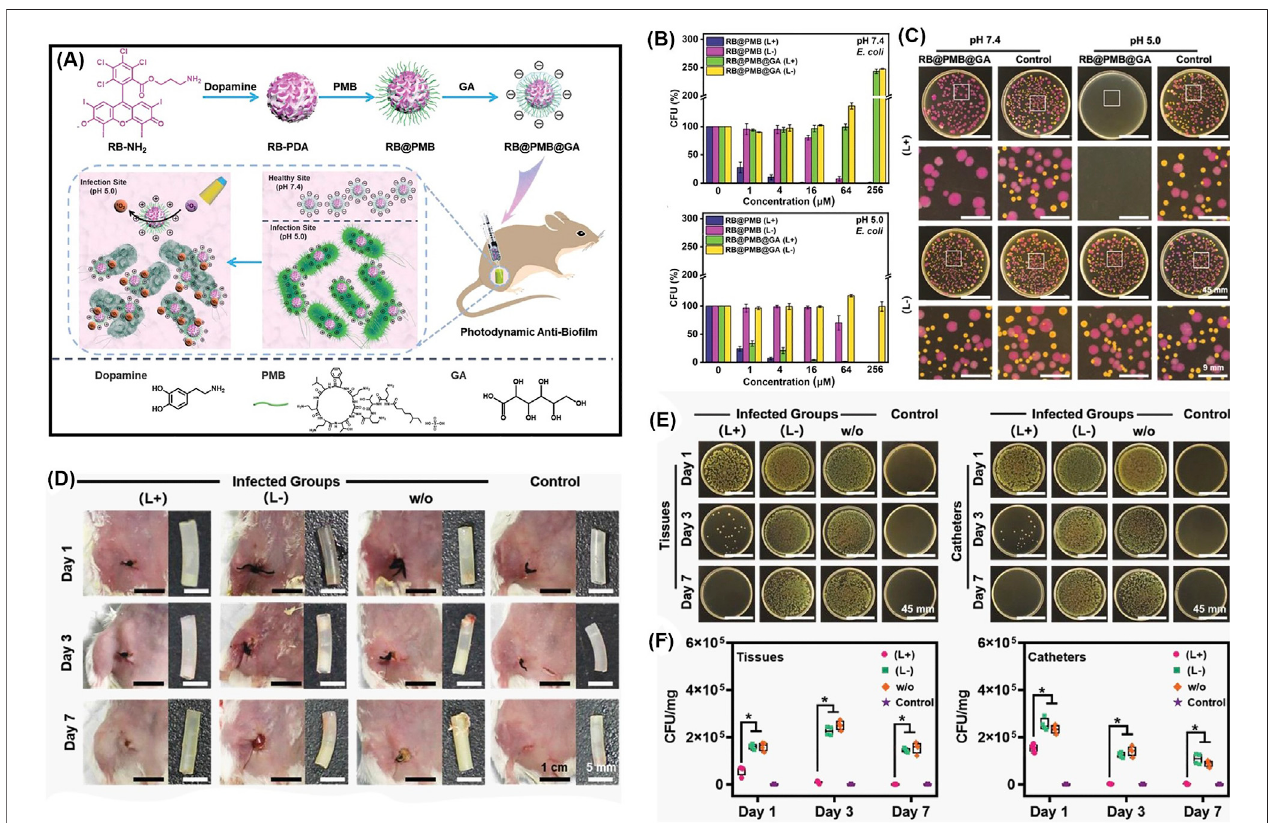
FIGURE 14 | (A) Schematic illustration of the preparation process of photodynamic NPs for enhanced penetration and antibacterial ef fi ciency in bio fi lms; (B) antibacterial activities against E. coli at pH 7.4 and pH 5.0, with or without irradiation; (C) photographs of E. coli labeled with the red protein and S. aureus colonies incubatedtogetherwiththedifferenttreatments; (D) typicalphotographsoftheincisionareasandimplantedcathetersfrommiceunderdifferenttreatmentsonDays1,3, and7; (E) photographsof P.aeruginosa bacterialcolonies,and (F) quantitativeanalysisofbacterialcolony-formingunitsobtainedfromthetissuesandcathetersin each group. Reprinted with permission from Wu et al.